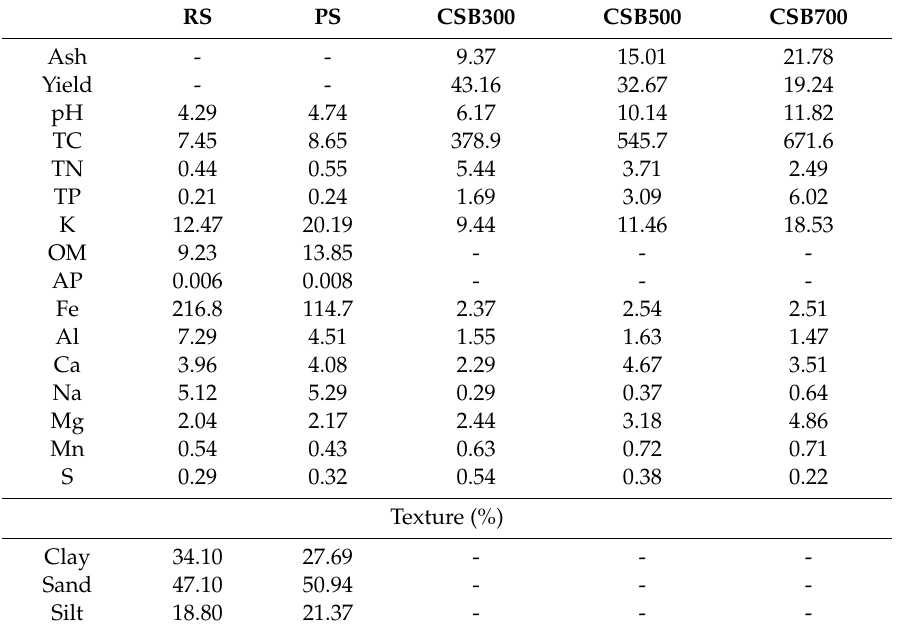
Table 1. Initial properties of two soil types and three di ff erent pyrolysis temperature CSB (g · kg − 1 ). RS PS CSB300 CSB500